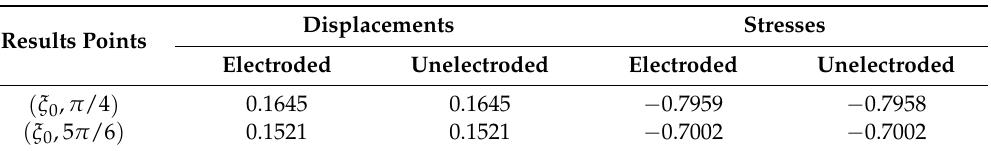
Table 1. The normalized displacement and stress of selected points on the boundary by solutions from electroded and unelectroded regions, respectively.